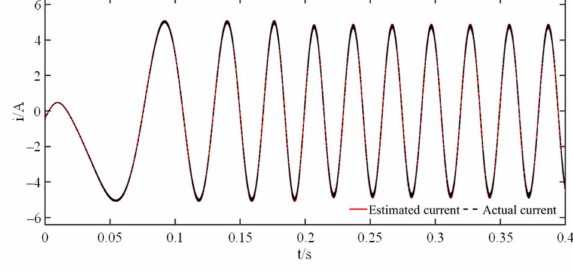
Figure 21. R = 0.0714 Ω .